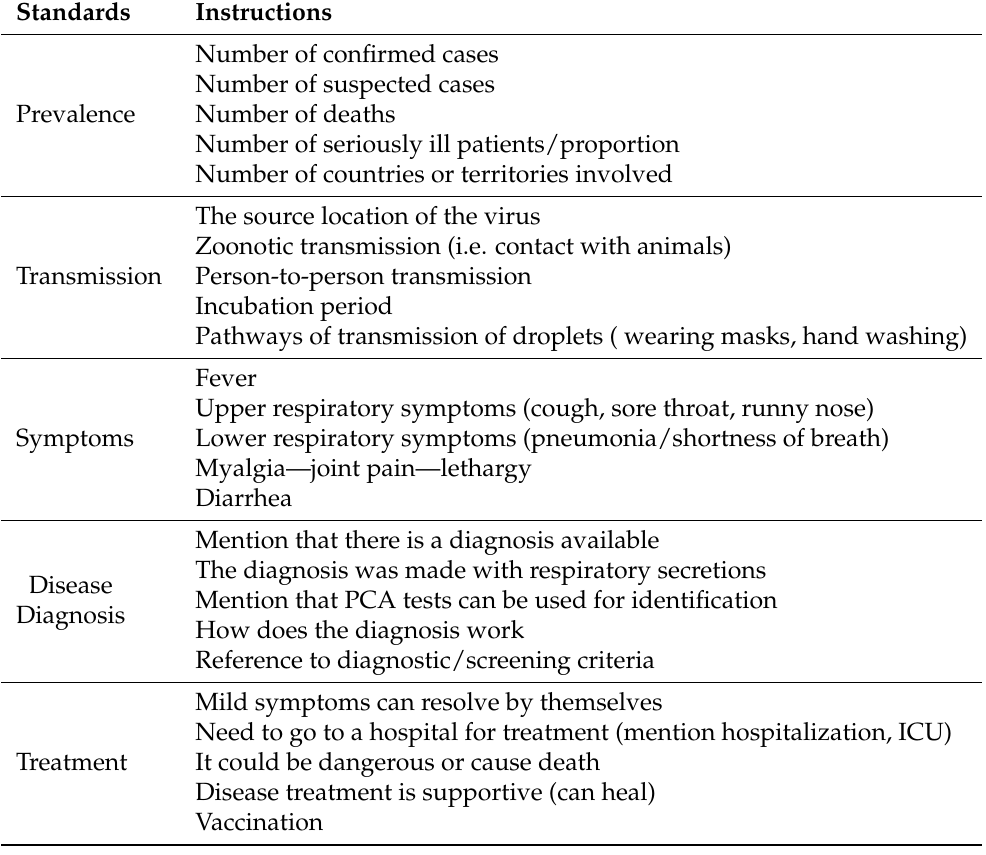
Table 4. MICI evaluation